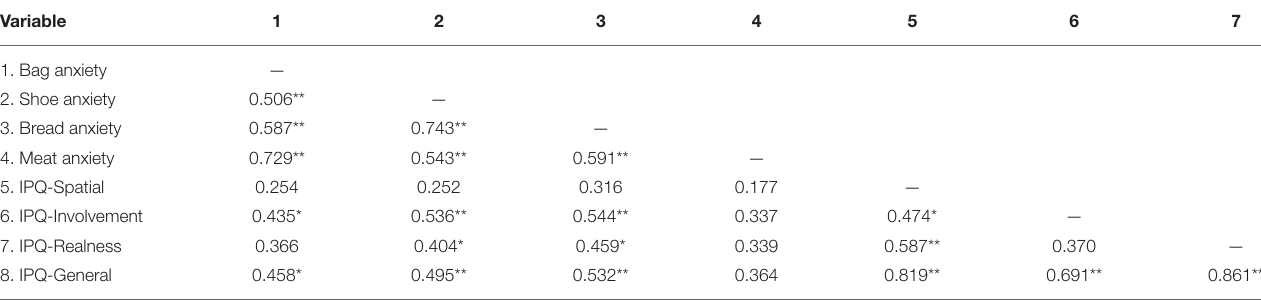
TABLE 2 | Spearman correlations between the anxiety and virtual presence variables.